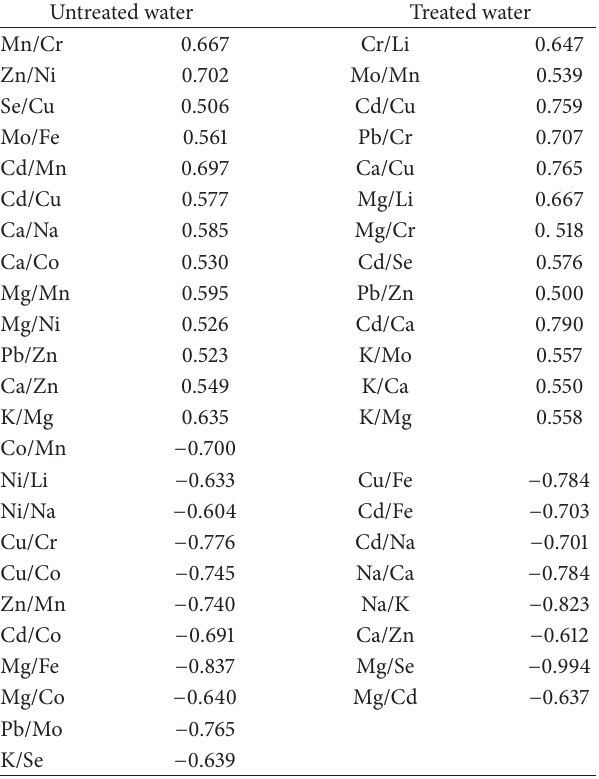
Table5:Correlationcoefficientbetweentraceelementsinuntreated and treated